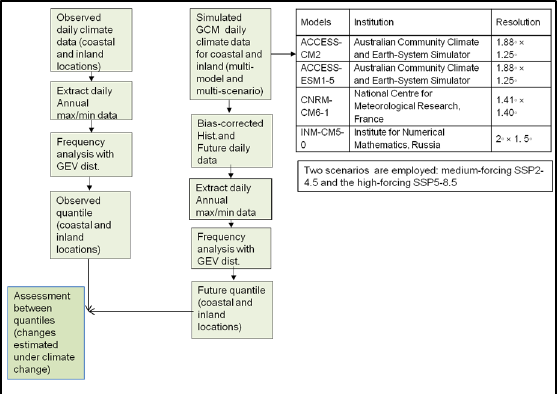
Figure 1. Proposed framework for evaluating climate extremes under climate change using a multi- model ensemble approach. The employed GCMs and scenarios are listed in the framework.